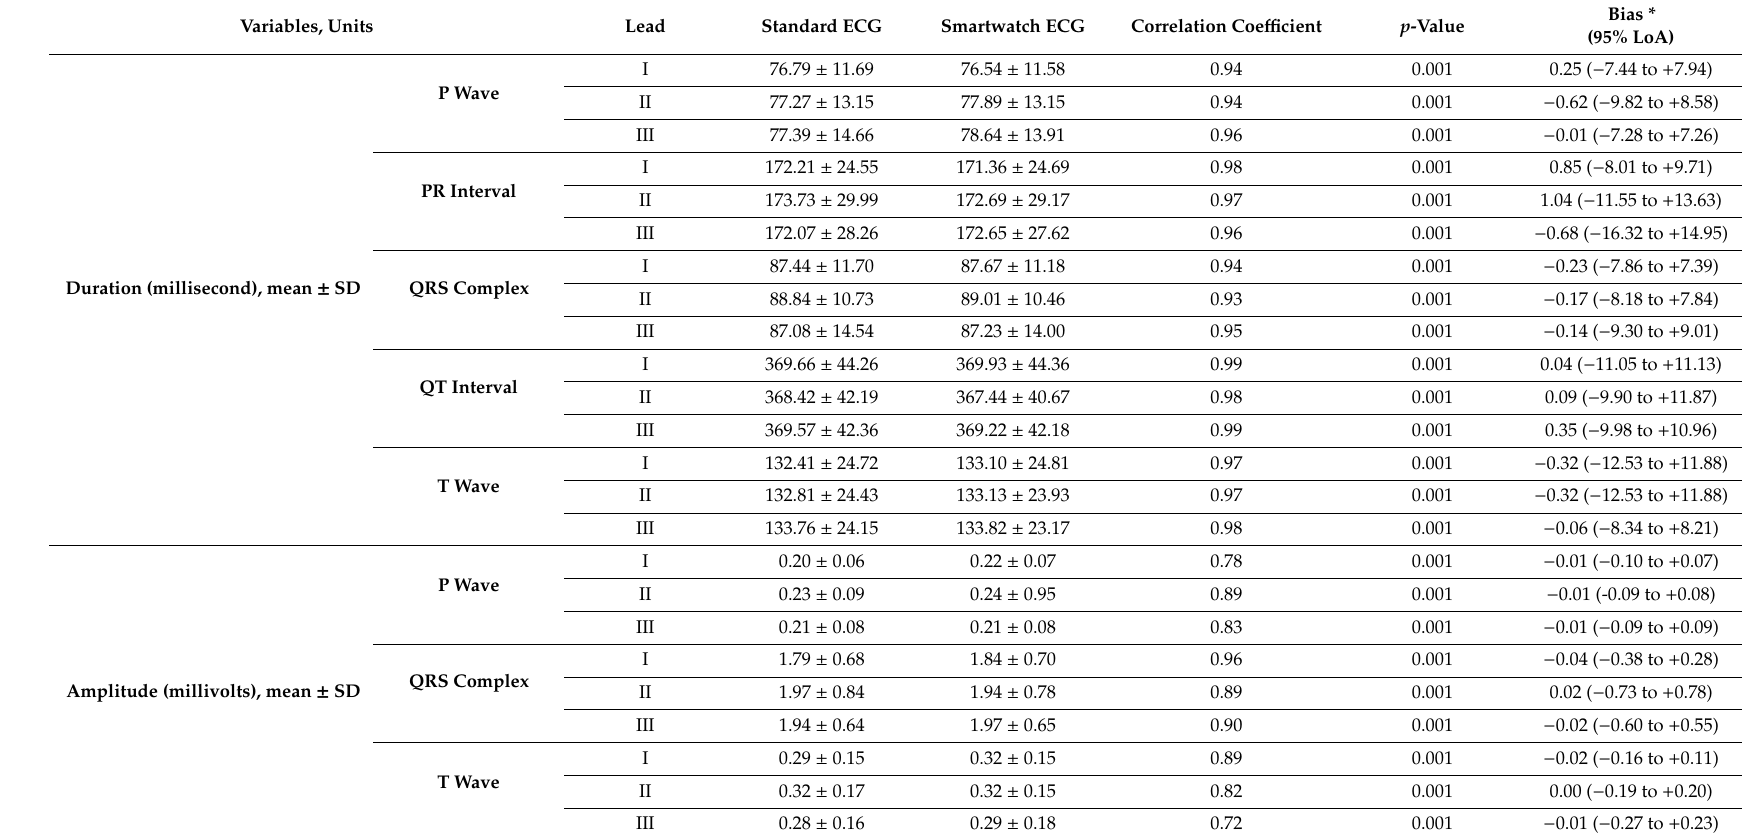
Table 2. Electrocardiogram characteristics (duration and